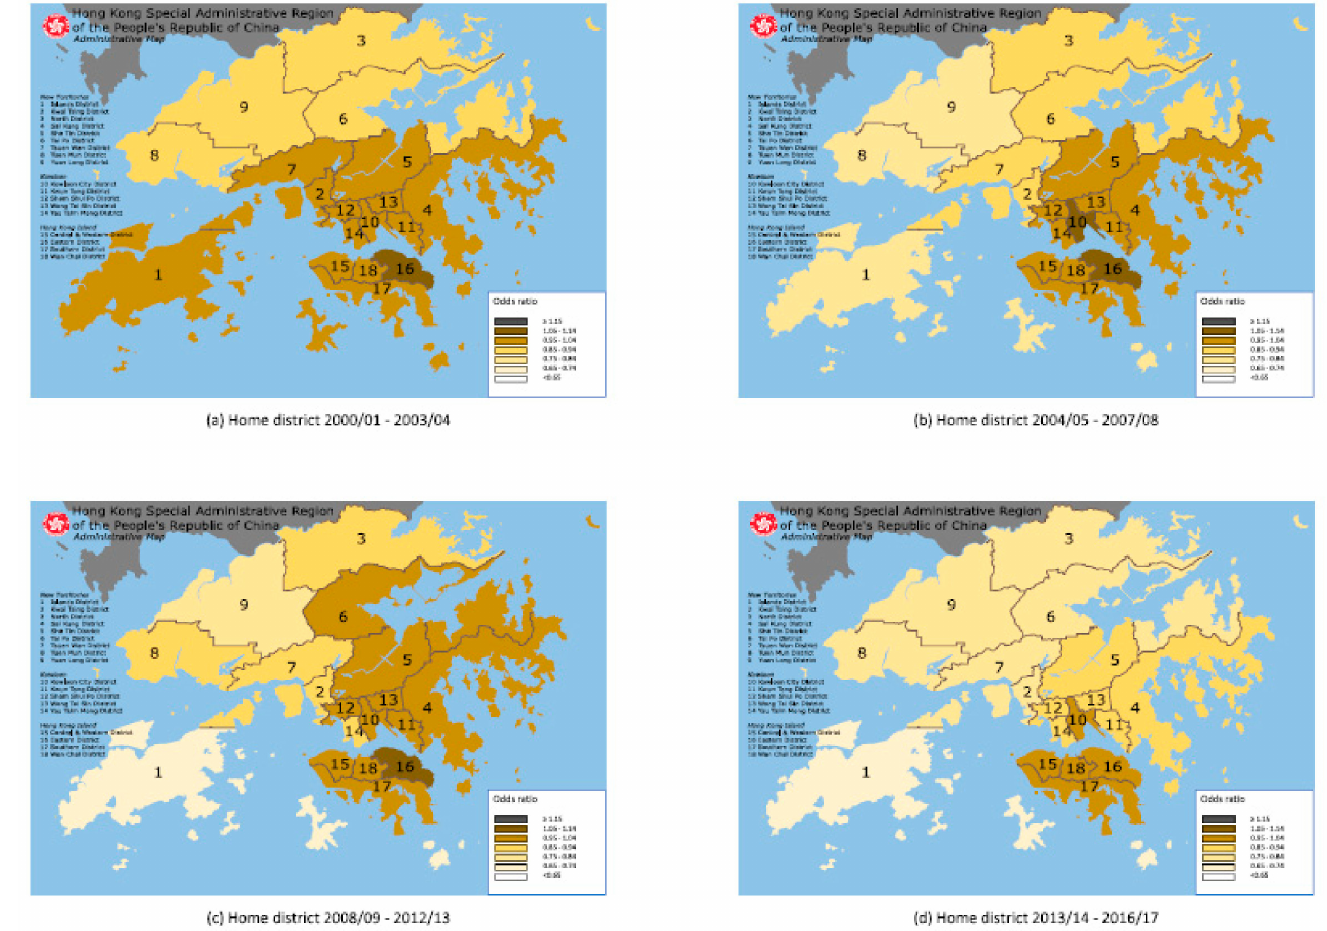
Figure 2. Map of 18 administrative districts in Hong Kong showing the adjusted odds ratio for reduced visual acuity by student’ s home district (17 districts relative to Central & Western District) during 2000 / 01–2003 / 04, 2004 / 05–2007 / 08, 2008 / 09–2012 / 13, and 2013 / 14–2016 / 17 (Modified map from original source: Wikimedia Commons (https: // commons.wikimedia.org / wiki /